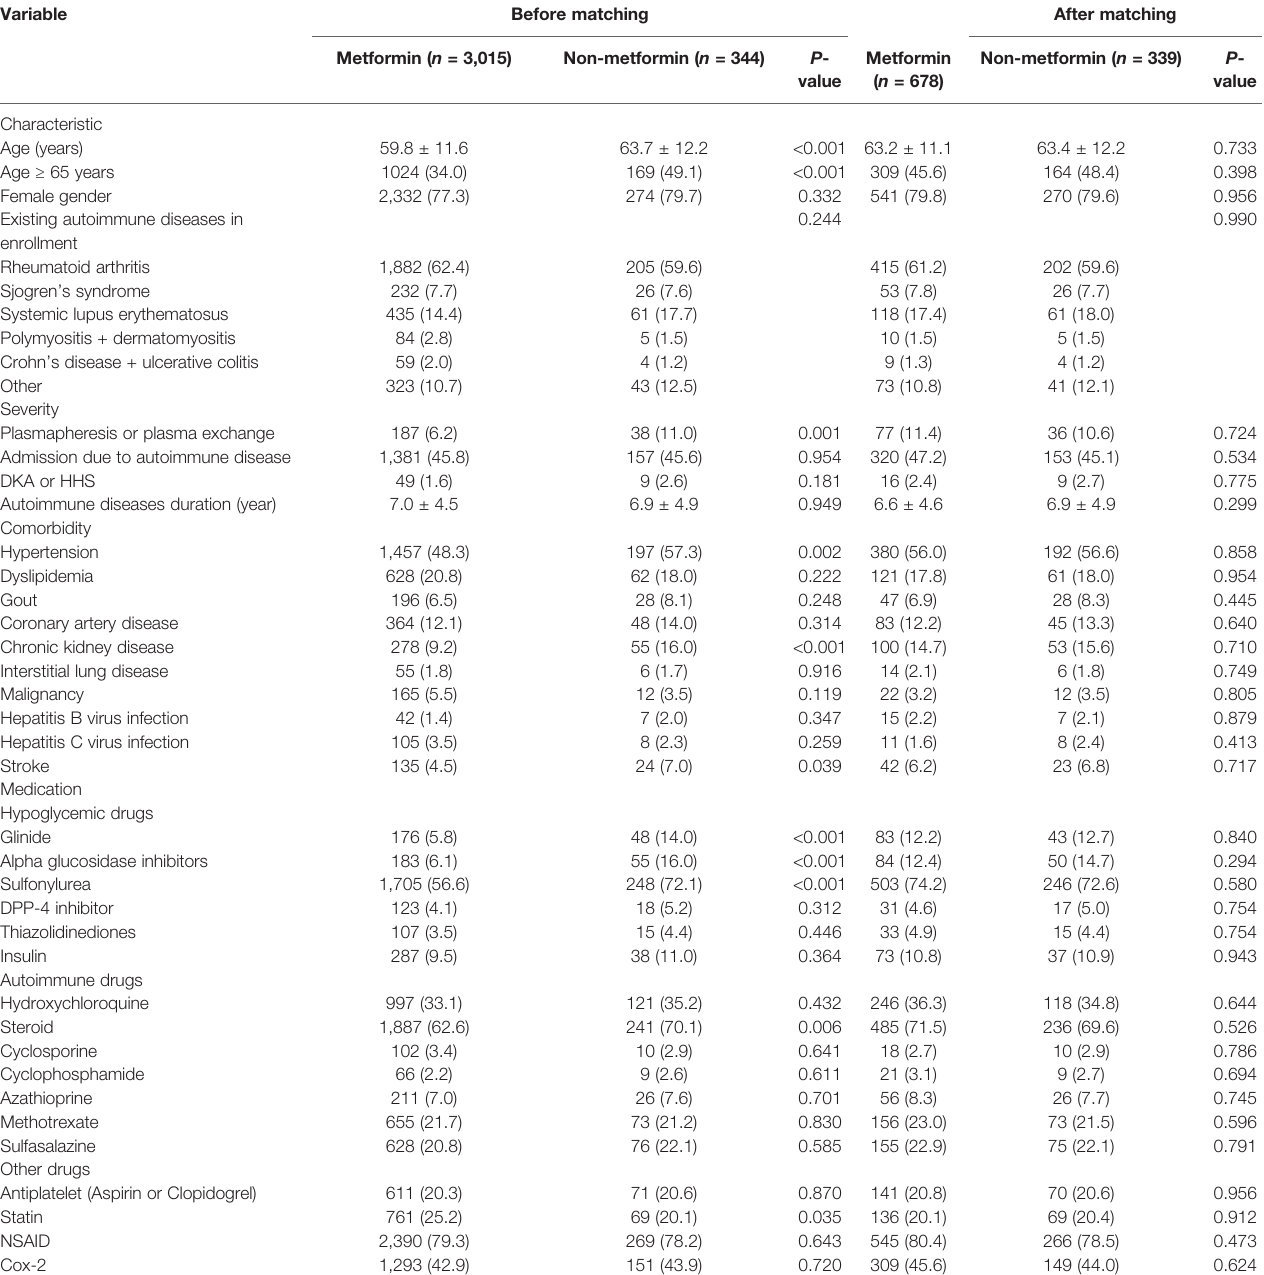
TABLE 1 | Characteristics of the study patients before and after propensity score matching. Variable Before